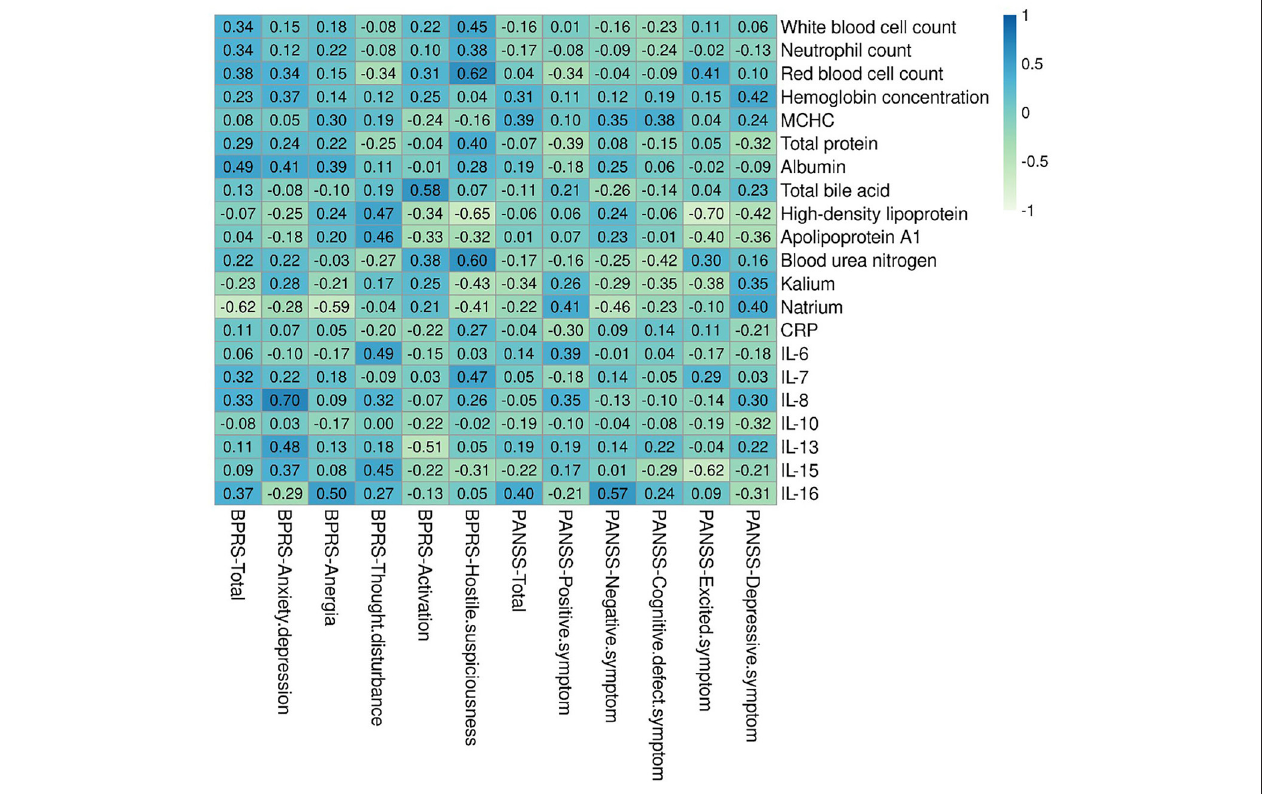
FIGURE 2 | Correlations heatmap of blood routine, biochemical, and inflammation cytokines with clinical symptom. There are six indexes had significantly positively and negatively connection with clinical indicators of BPRS, including red blood cell count, blood urea nitrogen, total bile acid, IL-8, Natrium, and High-density lipoprotein. There are three indexes had significantly positively and negatively connection with clinical indicators of PANSS. BPRS, Brief Psychiatric Rating Scale; PANSS, Positive and Negative Syndrome Scale.